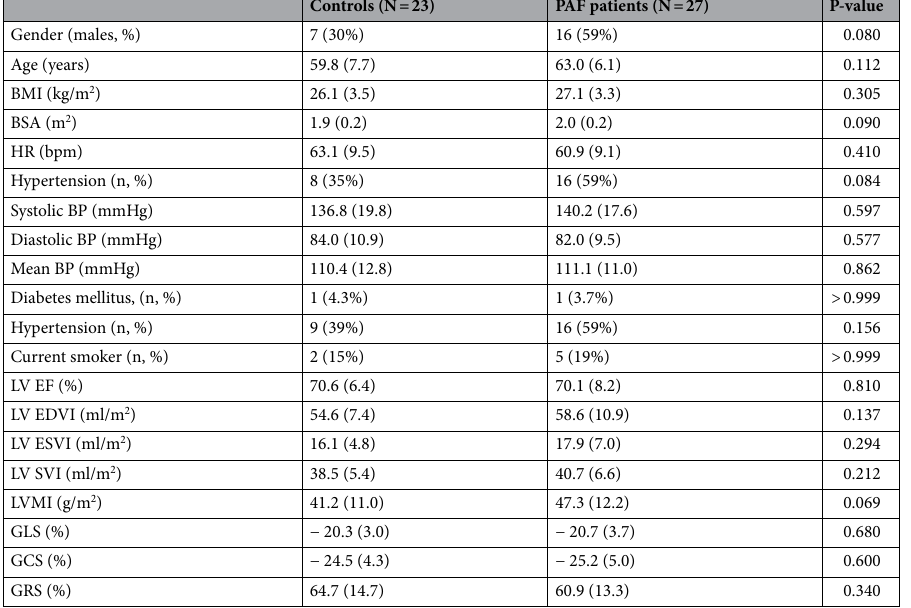
Table 1. General characteristics and comparison of left ventricular function and global strain between PAF patients and controls. Variables are expressed as numbers (percentages), mean (standard deviation) or median (interquartile range) for categorical, normally distributed, and non-normally distributed continuous variables, respectively. BMI body mass index, BP blood pressure, BSA body surface area, HR heart rate, LV left ventricle, EF ejection fraction, EDV, end-diastole volume, ESV end-systole volume, GLS global longitudinal strain, GCS global circumferential strain, GRS global radial strain, I indexed, LVM left ventricular mass, n number of subjects, PAF paroxysmal atrial fibrillation, SV stroke volume.